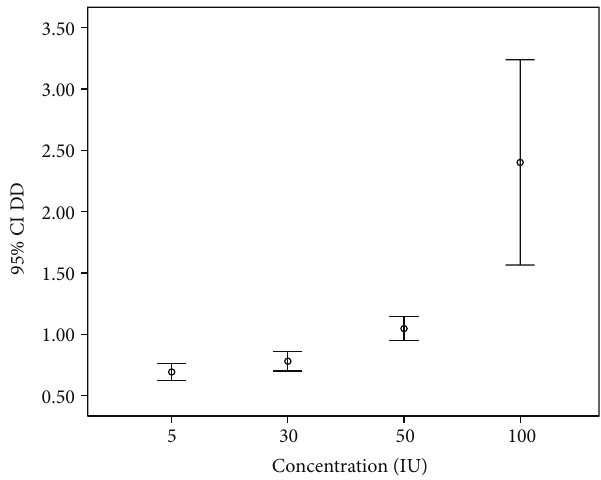
Figure 3: D-dimer level ( 𝜇 g/mL) against various concentrations (IU/mL) of streptokinase using Box-and-Whisker plot.